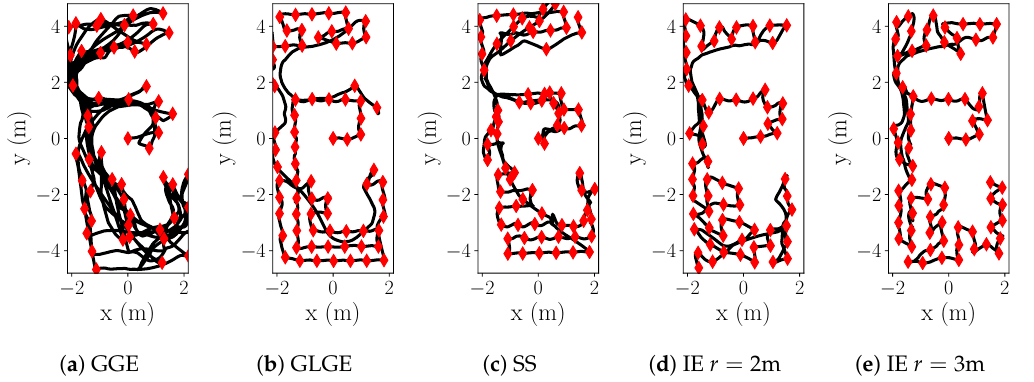
Figure 15. E1: Trajectories comparison, k = 3 l